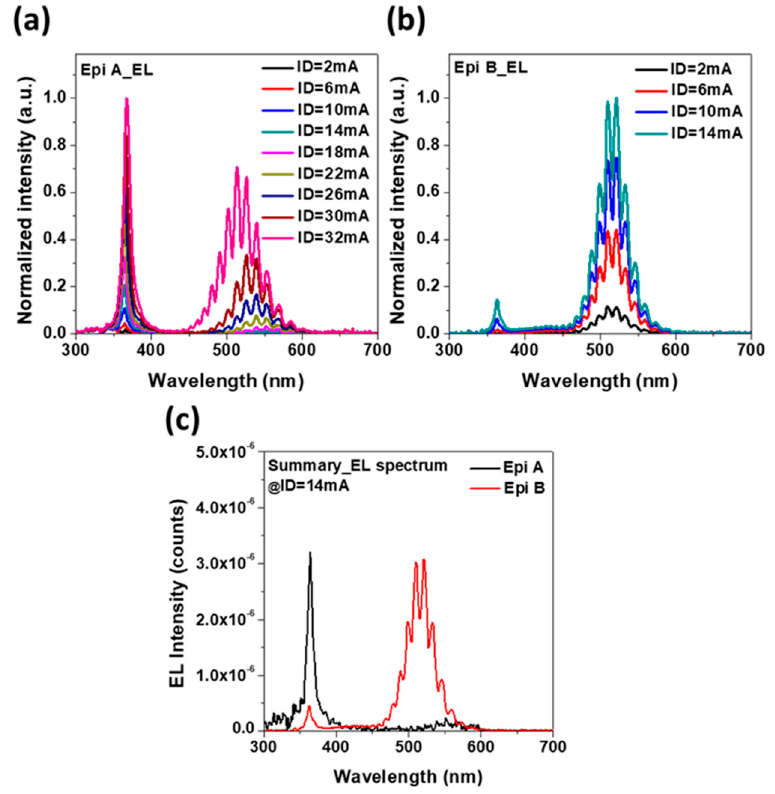
Figure 5. Normalized intensity of Electroluminescence spectrums of LE-HEMTs at different drain current on ( a ) epi A and ( b ) epi B. ( c )Relative intensity of Electroluminescence spectrums of LE-HEMTs at I D = 14 mA on different epitaxy structures.